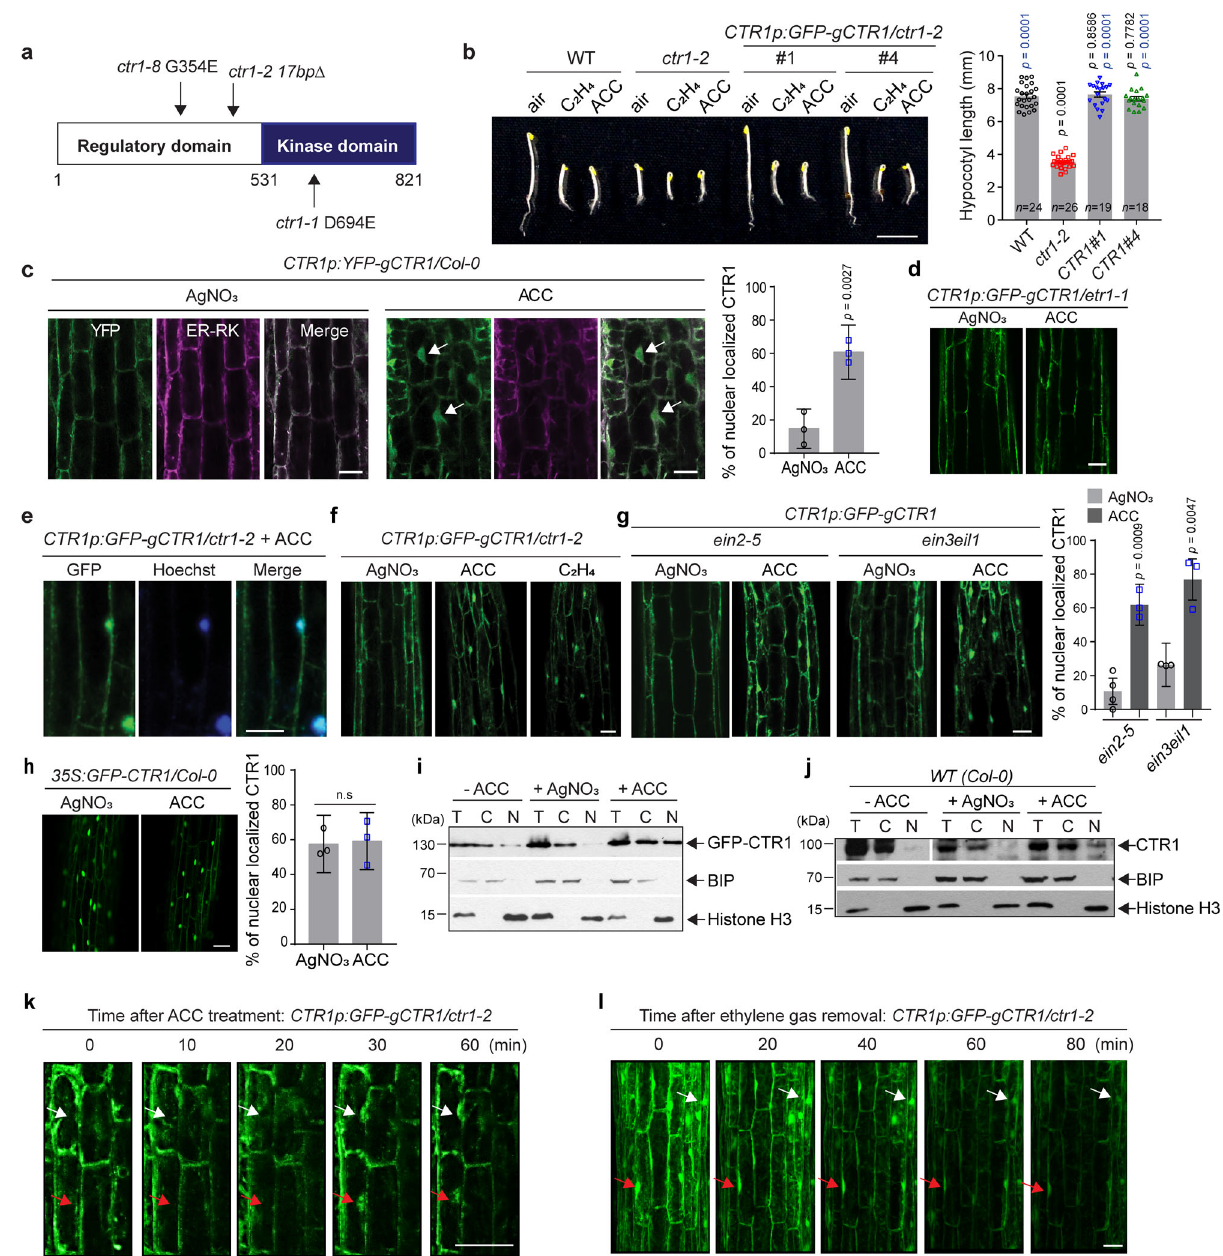
Fig. 1 | Ethylene-activated CTR1 translocation to the nucleus does not require EIN2 and EIN3. a Diagram of the CTR1 protein and the positions of ctr1 mutant alleles. b The GFP-fused wild-type genomic CTR1 fragment fully rescues ctr1-2 and confers an ethylene response. Seedlings were grown for 3 d in the dark with or without ACC or ethylene. The graph represents the quanti fi cation of hypocotyl lengthsofseedlingsgrownonMSwithoutACC.MS,MurashigeandSkoogmedium. Signi fi cance was determined by one-way ANOVA with Dunnett ’ s multiple compar- isons test to compare the results to the WT (black) and ctr1-2 (blue) controls. Error bars, SE. Scale bar, 5mm. c YFP-CTR1 co-localizes with ER-RK and translocates into the nucleus in the presence of ACC. The areas below the hook and above the elongation zone were imaged. ER-RK 62 , an RFP-fused ER marker. Arrows indicate nuclear-localized YFP-CTR1. The graph represents the ratio of nuclear-localized CTR1indark-grownseedlings.Errorbars,SE( n =3seedlings). d GFP-CTR1doesnot translocateintothenucleusin etr1-1 mutant. e GFP-CTR1 fl uorescenceoverlapswith Hoechst nuclear staining under ACC treatment. f Ethylene and ACC activate CTR1 nuclear translocation. g Seedlings expressing GFP-CTR1 in ein2-5 or ein3eil1